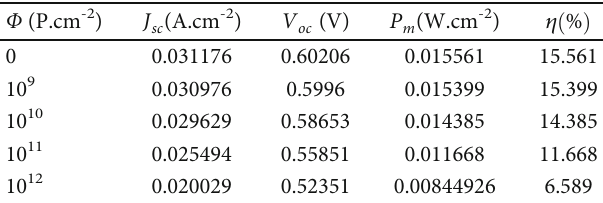
Figure 6: E ffi ciency versus fl uences ( L Table 1: E ff ect of the irradiation on the solar cell electrical